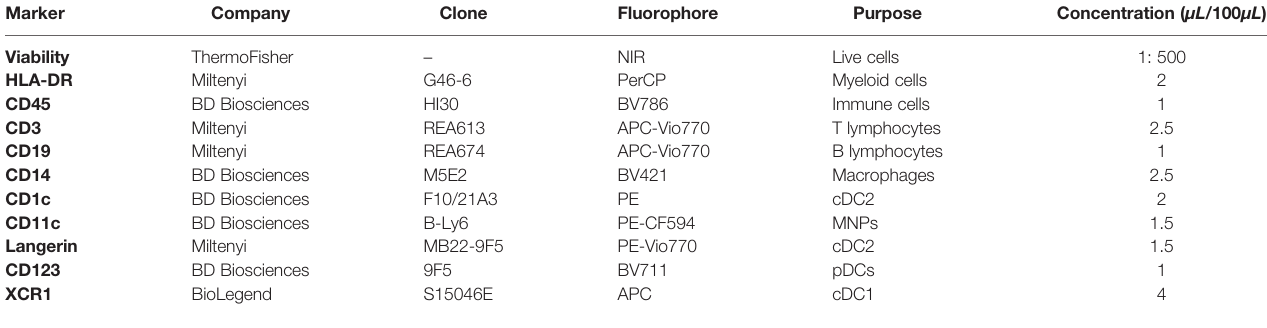
TABLE 2 | FACS Aria sort